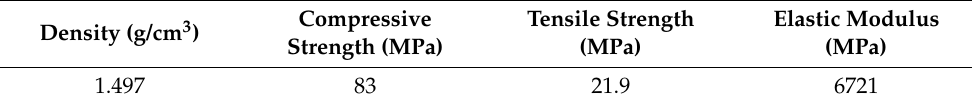
Table 3. The mechanical properties of the polyurethane concrete. Density (g/cm 3 )